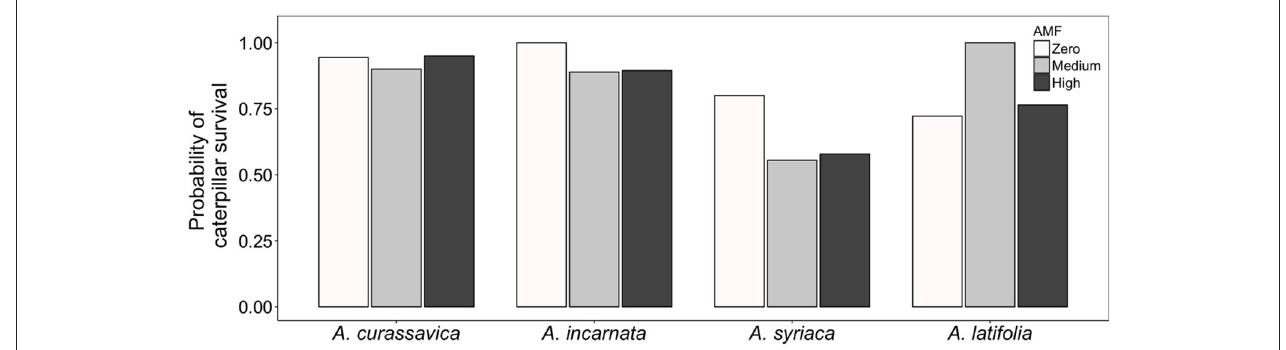
FIGURE 3 | Effect of AMF inoculum availability on the probability of caterpillar survival on four milkweed species. Sample sizes range from 17 to 20 caterpillars ( = replicate plants) per plant species × AMF treatment.